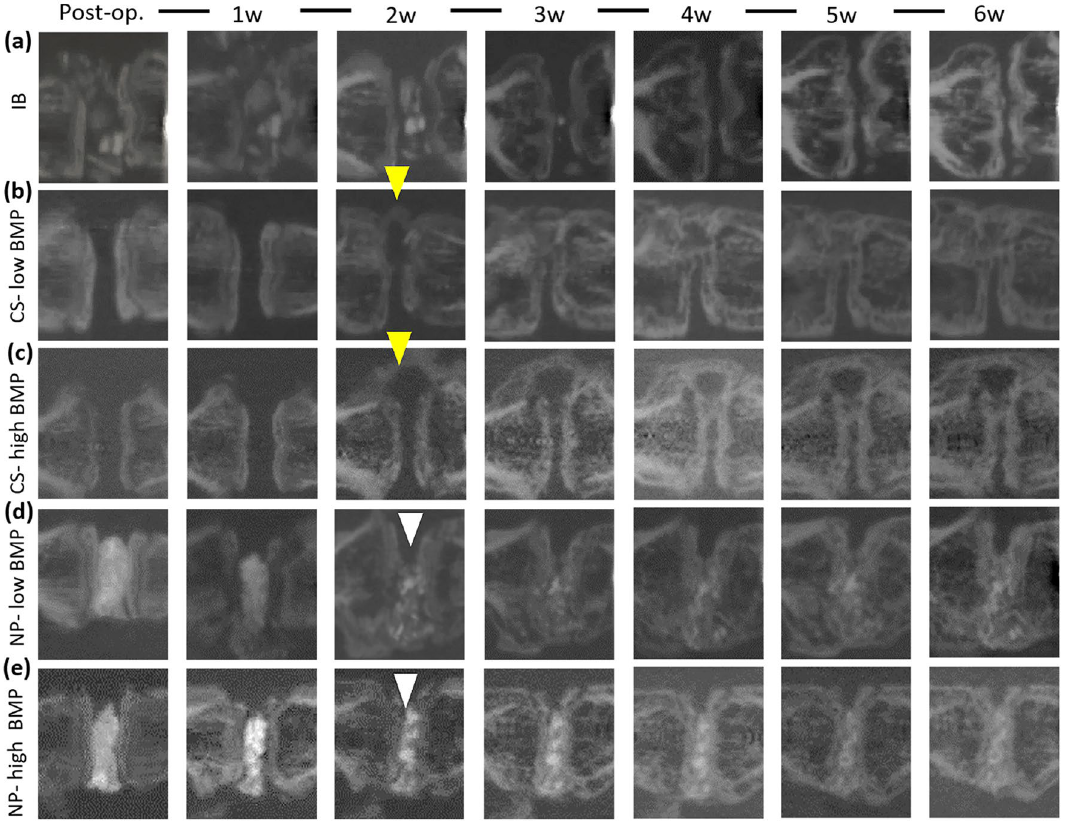
Figure 2. Temporal in vivo micro-CT images of the treated segments. In the IB group, the grafted bone was absorbed over time and almost disappeared at 6 weeks postoperation ( a ). In the CS group, new bone formation outside the disc space was observed at 2 weeks postoperation. The amount of new bone formation at the intervertebral disc space was limited until 6 weeks postoperation ( b , c ). In the NP groups, the density of HA and β-TCP decreased over time. New bone formation, limited to the disc space, was observed at 2 weeks postoperation, and the density of the new bone increased over time until 6 weeks postoperation ( d , e ).